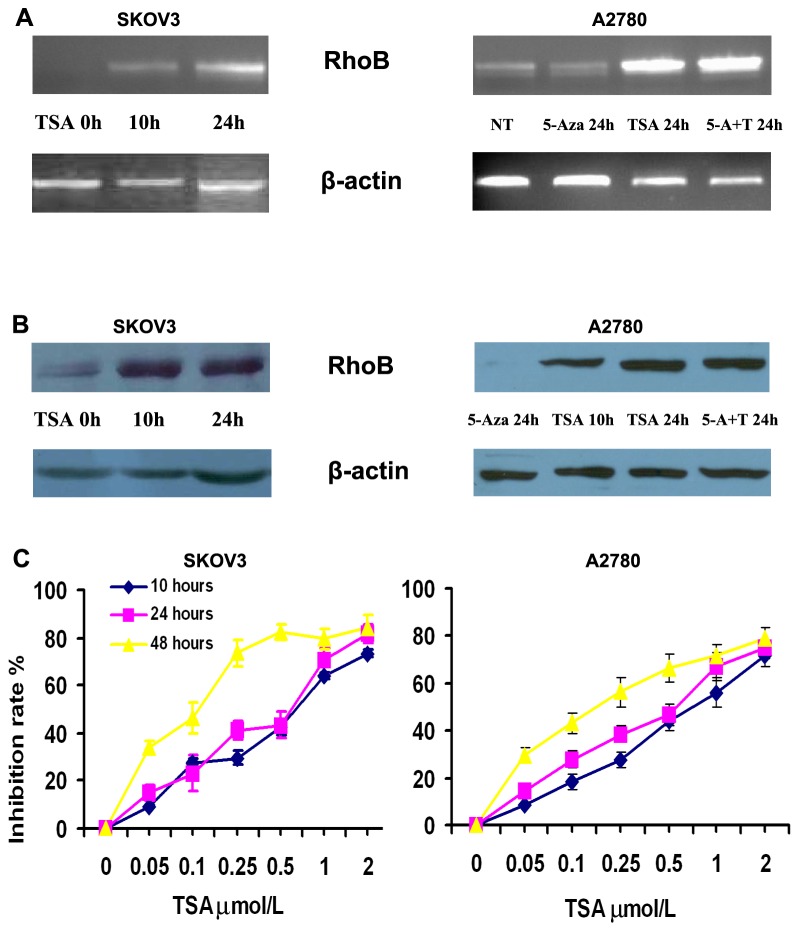
Restoration of expression loss of RhoB gene.Regulation of RhoB expression loss by histone deacetylase (HDAC) inhibitor trichostatin (TSA) and methyltransferase inhibitor 5-Azacytidine (5-Aza). (A) Semi-quantitative RT-PCR analysis of RhoB expression levels in ovary carcinoma cell: Cells were either nutreated (NT), treated with 5-Aza at 2 μM, with TSA at 0.5 μM, or with combination of TSA (0.5 μM) and 5-Aza (2 μM). It can be seen that 5-Aza did not increase RhoB expression. However, TSA could significantly reverse RhoB silencing in ovary cancer SKOV3 and A2780 cells. β-Actin was used as inner control. (B) The expression confirmation of RhoB by Western blotting analysis: SKOV3 and A2780 cells were exposed to 0.5μM TSA at different time points. β-actin was used as equal loading control. As shown, TSA treatment, but not 5-Aza, revived the protein expression of RhoB. (C) TSA-mediated cell growth arrests of ovary cancer cells: SKOV3 and A2780 cells were treated with gradient TSA for 10, 24 and 48 hours. The inhibition rate was calculated as a percentage of the in
vitro proliferation in terms of untreated control cells by MTT. TSA inhibits SKOV3 and A2780 cells growth in a concentration- and time-dependent manner. The results were expressed as mean±S.D.